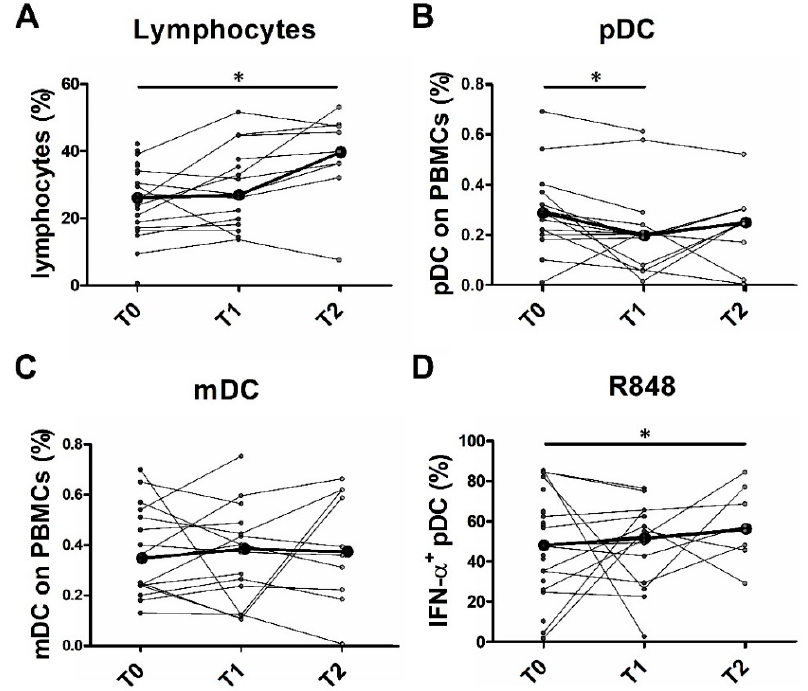
Figure 7. Frequency of peripheral blood immune cells and IFN- α + pDCs in BRAF V600 + MM patients over therapy administration. Cell counts ( A ) and flow cytometry ( B , C ) analysis were performed on whole blood from BRAF V600 + MM patients before therapy initiation (T0; n = 16), after 30 days (T1; n = 12), and after 120 days (T2; n = 9) from therapy administration ( A – C ). Total PBMCs isolated from peripheral blood of MM patients were cultured in RPMI 1640 medium and stimulated with R848 for 2 h ( D ). IFN- α was analyzed by intracellular flow cytometry staining ( D ). Before–after graphs illustrate the frequency of lymphocytes ( A ), pDCs ( B ), and mDCs ( C ) on total PBMCs, and the frequency of IFN- α + pDCs on BDCA-2 + / CD123 + cells ( D ) for each subject. Bold black lines represent the median values. The statistical significance was calculated by Wilcoxon signed-rank test. * p < 0.05.